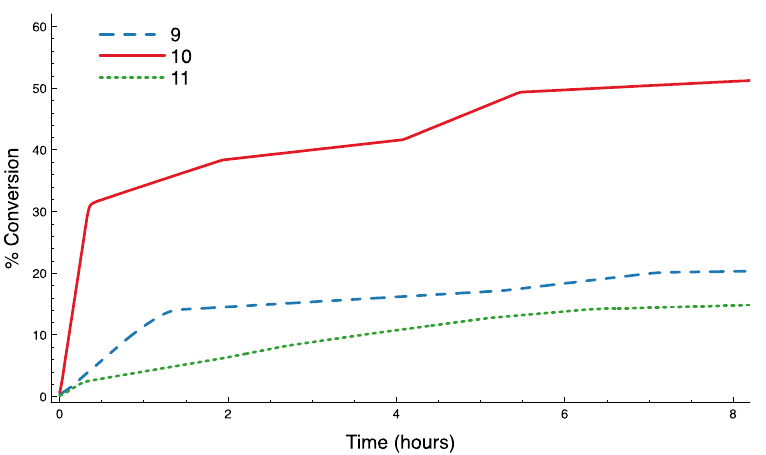
Figure 6. Percent catalytic conversion of cyclohexene sulfide to cyclohexene with 3 mol% complexes 9 , 10 , and 11 , monitored via 1 H-NMR spectroscopy.